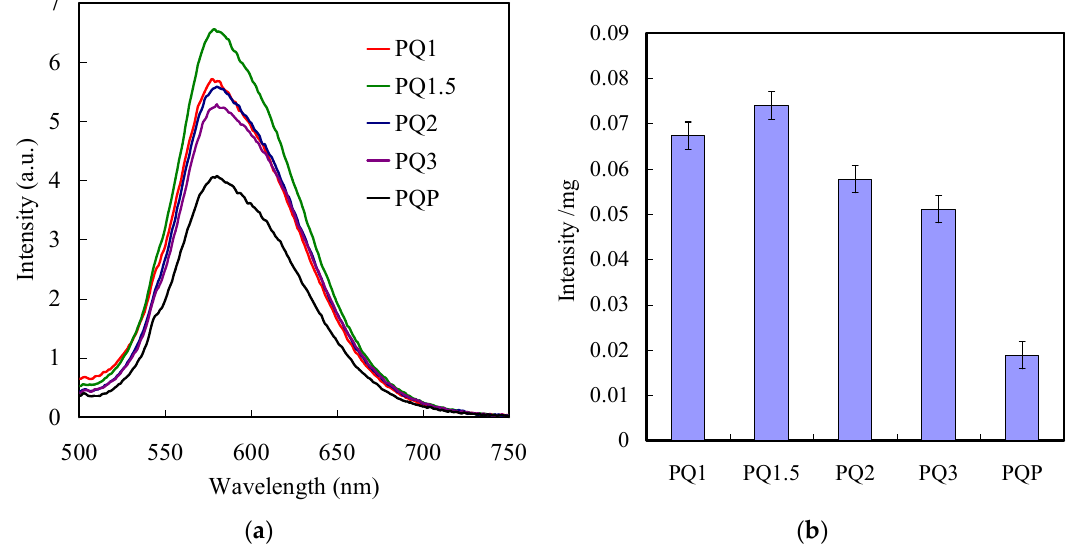
Figure 5. PL emission spectra of ( a ) PQ1, ( b ) PQ1.5, ( c ) PQ2, ( d ) PQ3, and planer sample.